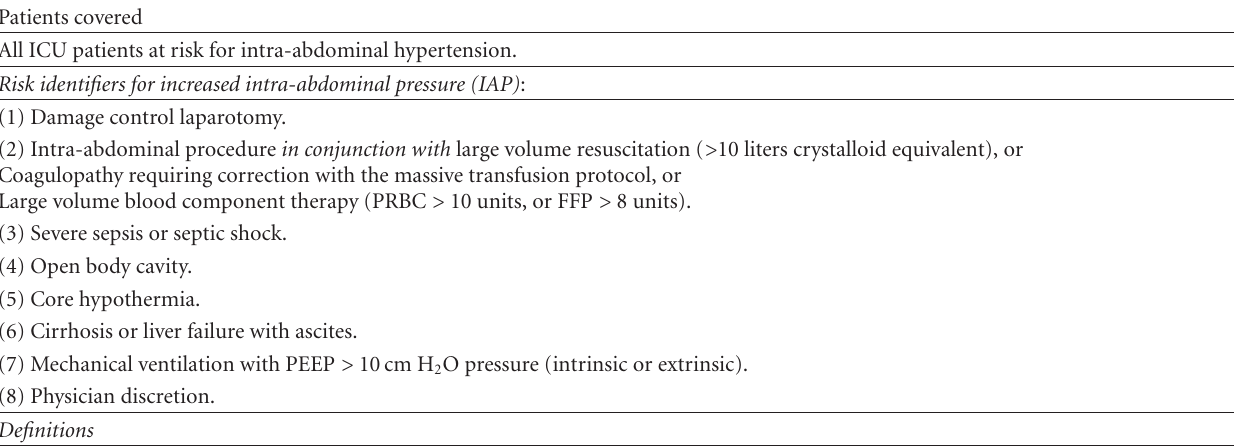
Table 2: Bladder pressure monitoring